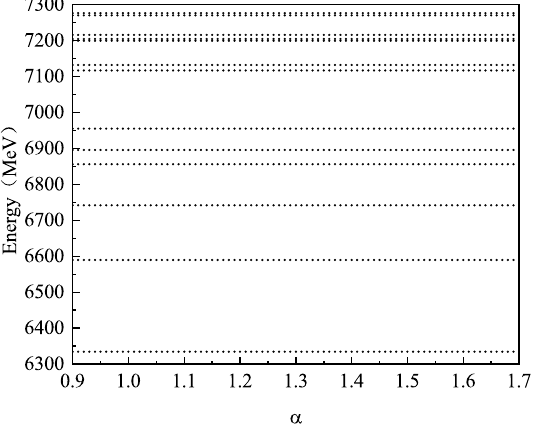
Figure 12. The stabilization plots for the energies of the states for J PC = 2 ++ obtained by considering the full hidden-channels coupling with respect to the scaling factor α .